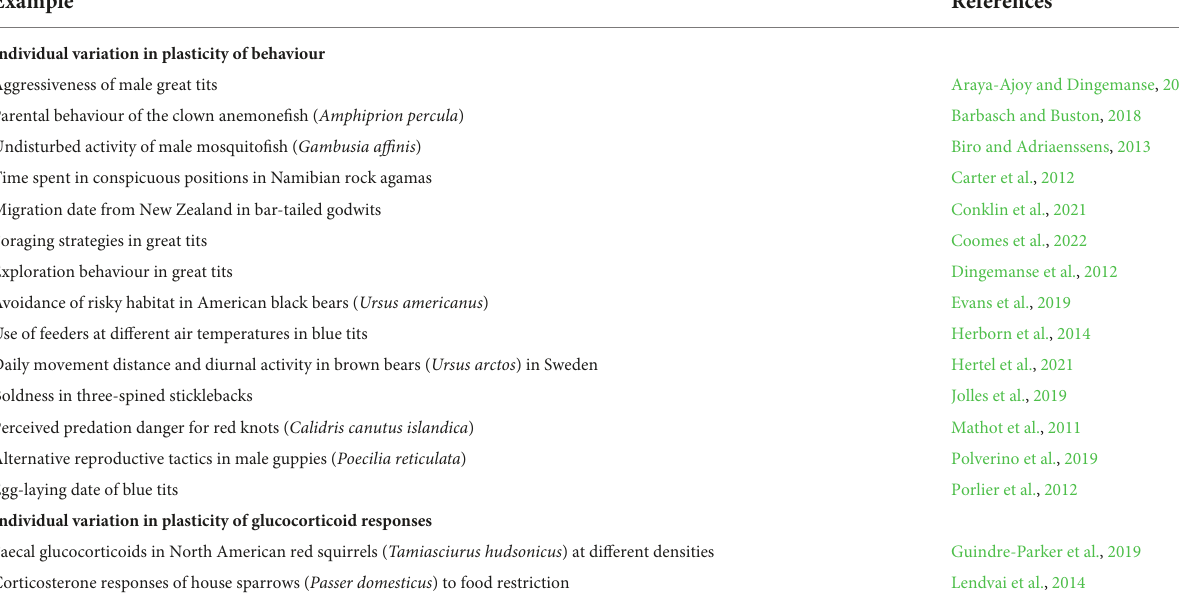
TABLE 3 Examples of individual variation in plasticity of behavioural and physiological responses of animals to changes in their environment.